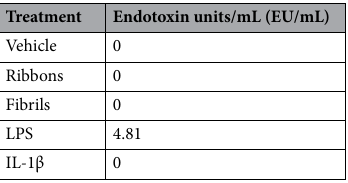
Table 2. Quantification of endotoxins in the α-syn preparations and inflammatory stimuli used on primary human brain pericytes and